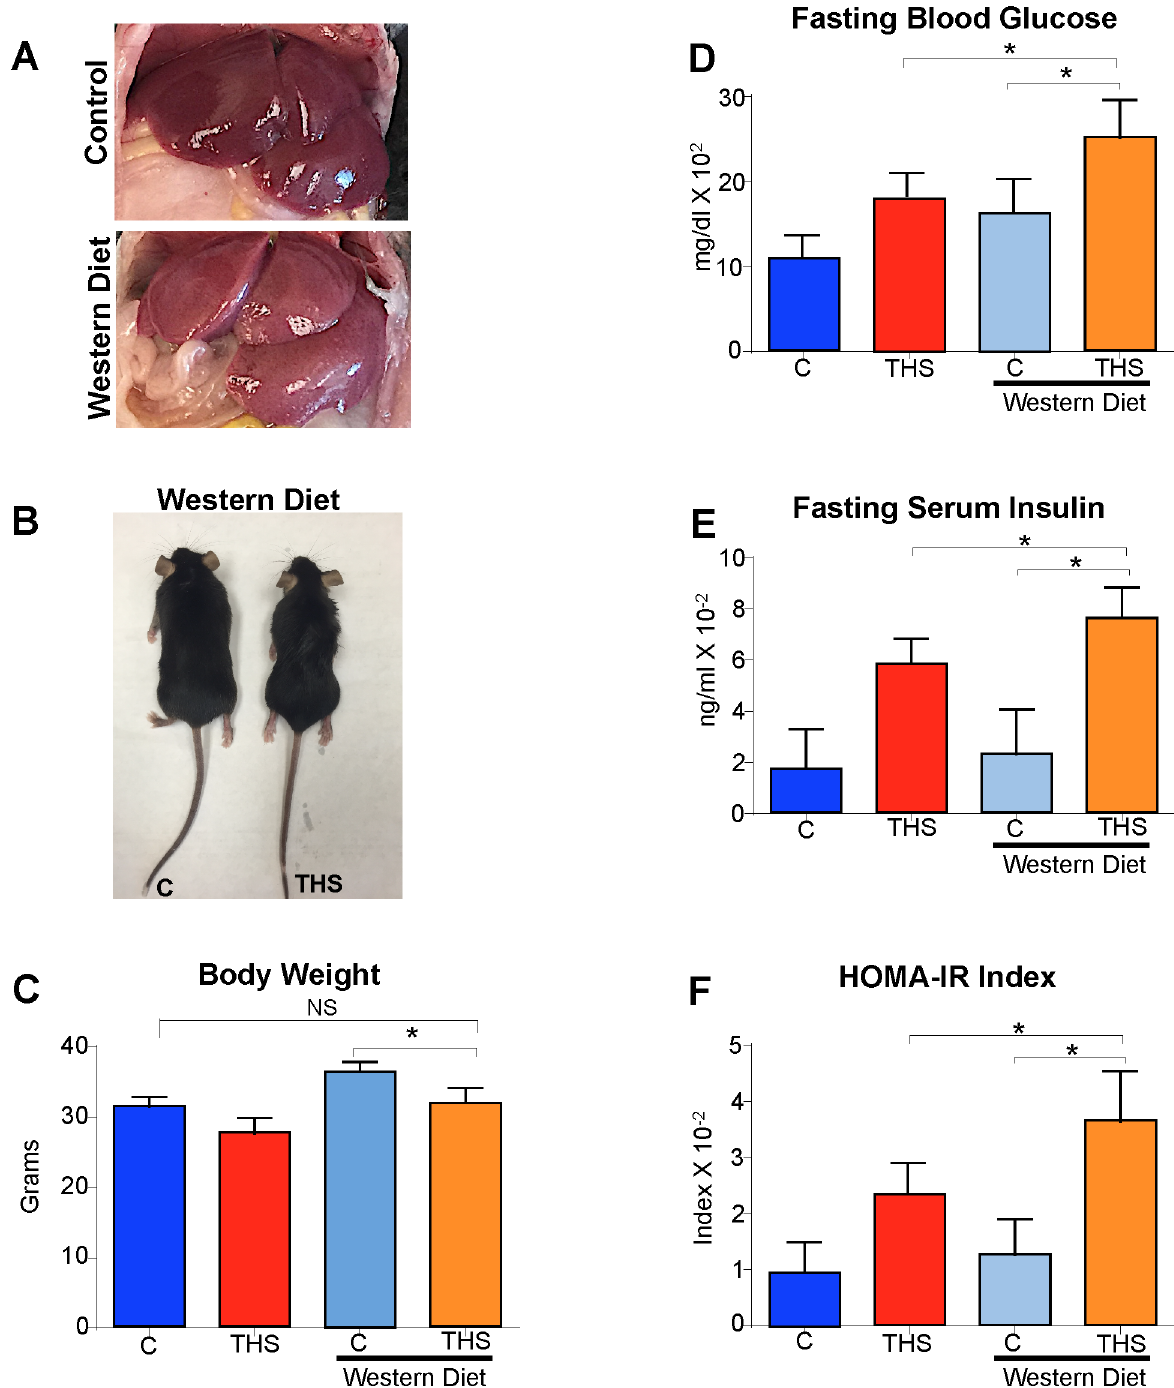
Fig 5. THS exposure in conjunction with “ western diet ” increases metabolic syndrome. THS exposed mice on “ western diet ” have increased fat accumulation in the liver (A) , are leaner than control mice on “ western diet ” (right mouse) (B) , weigh less than control mice on western diet (C) , have increased fasting blood glucose compared to control and THS-exposed mice (D) , have increased fasting insulin levels compared to control and THS- exposed mice (E) , and have an increased HOMA-IR index (fasting blood glucose X Fasting insulin/22.5) compared to control and THS-exposed mice (F) . All data are Mean ± SD . * = p < 0.05, ** = p < 0.01. NS = Not statistically significant . n = 6. P values were adjusted for the number of times each test was run . “ Fold change ” on western Blot graphs indicate fold change to control .